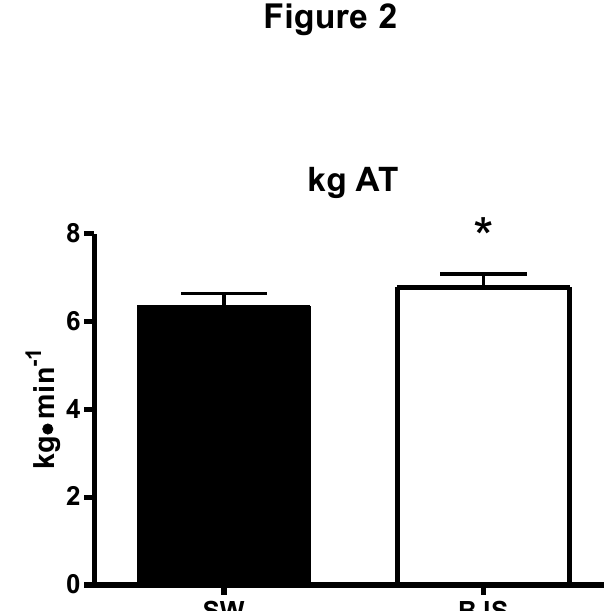
Table 1. baseline level in oxygen uptake (VO pulmonary ventilation (VE) and heart rate (HR) at rest before control swimming (CSW) and beetroot juice supplementation (BJS) tests.